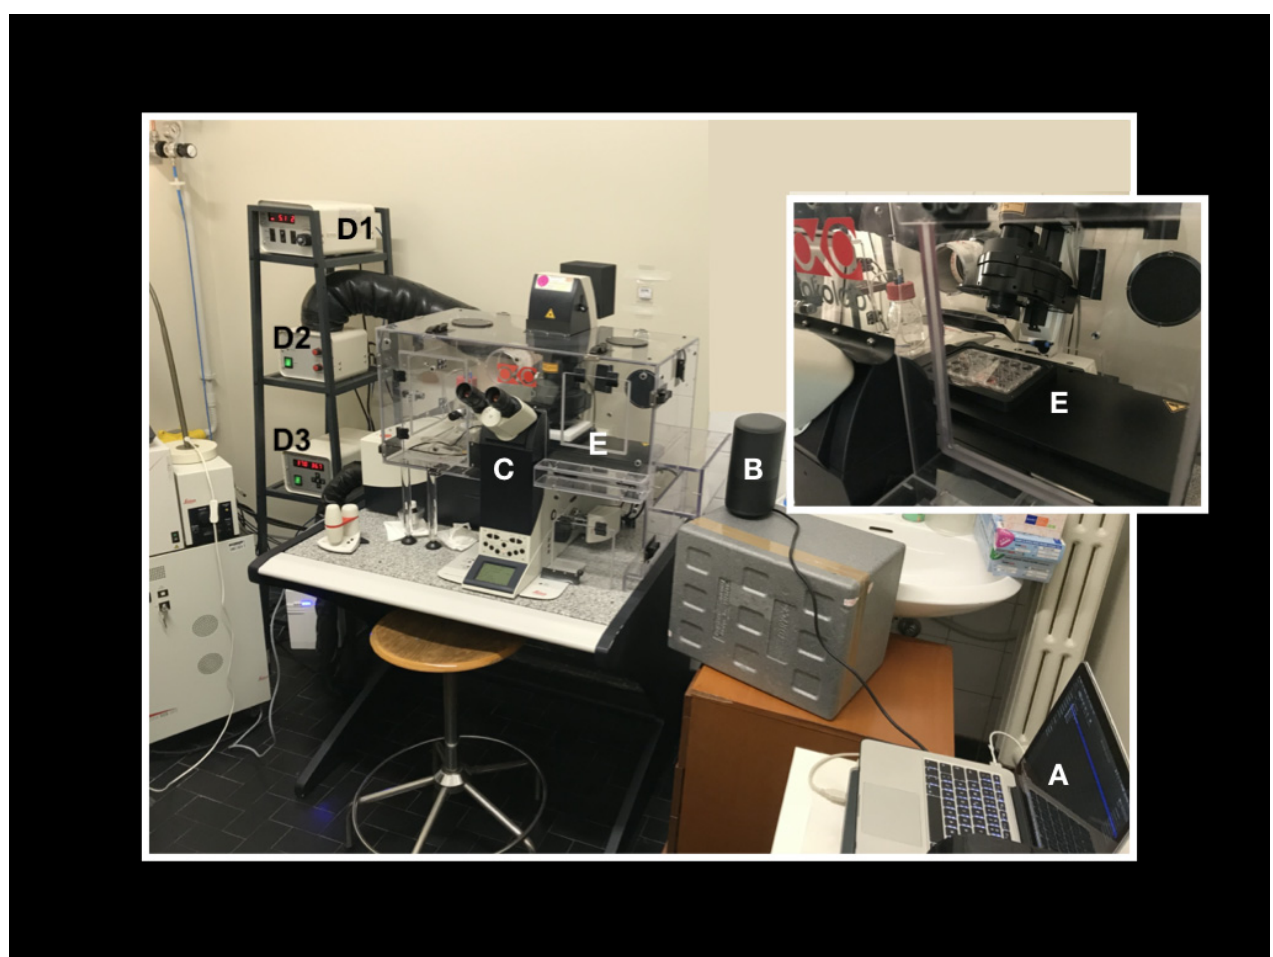
Figure 5. Our laboratory set up for the experiment. A laptop computer with the audio tracks ( A ) is connected to an amplifier ( B ) positioned nearby the microscope ( C ) and its incubator ( E ). With a phonimeter we calibrated the volume of the amplifier so that the intensity of the sound in the point where the cells are positioned ( E ) is about 60 dB, which corresponds to a normal vocal conversation. ( D1 ) CO 2 controller, ( D2 ) heating unit, temperature control unit ( D3 ). We remark that also “control cells” were exposed to the speaker plugged to energy without any sound produced in order to exclude that our findings could be the result of any small vibration produced by the speaker itself instead of the sound. Finally, the vocal sounds used were pronounced by 3 different people, giving the same results.